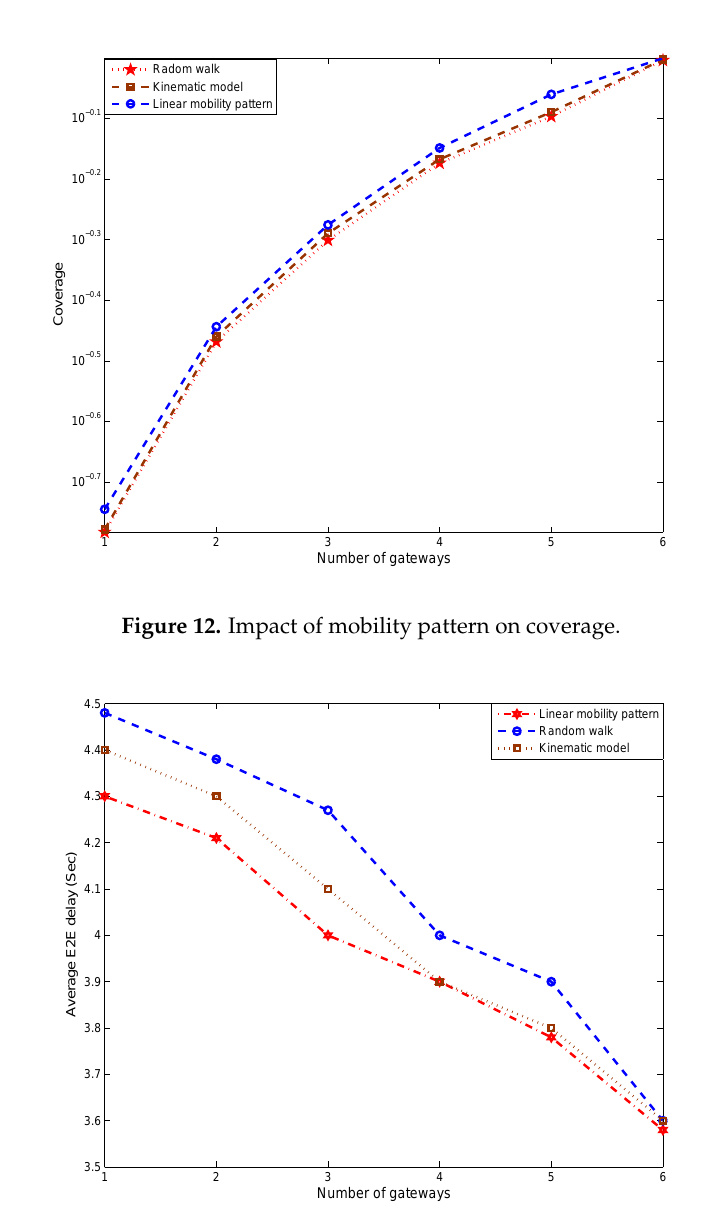
Figure 13. Impact of Mobility pattern on end-to-end